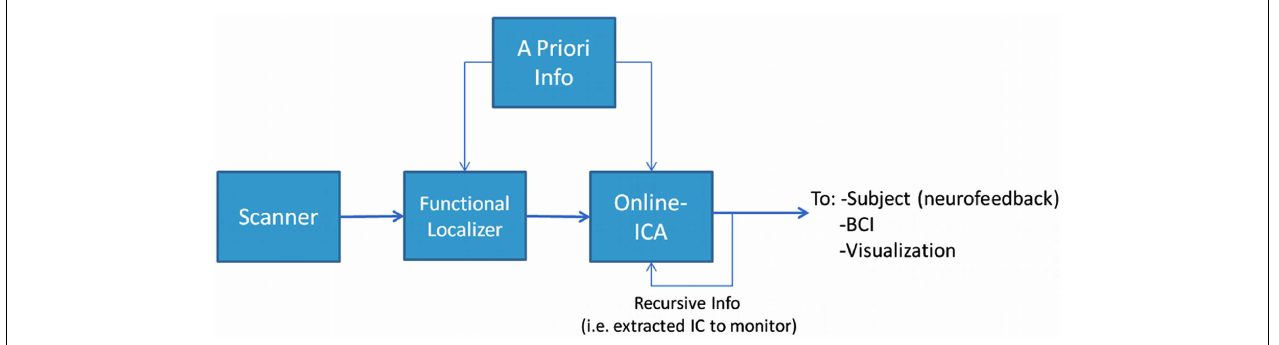
with or without incorporating some kind of a priori knowledge.The second step is to monitor the phenomenon we identified in the previous step using a suitable on-line analysis method.